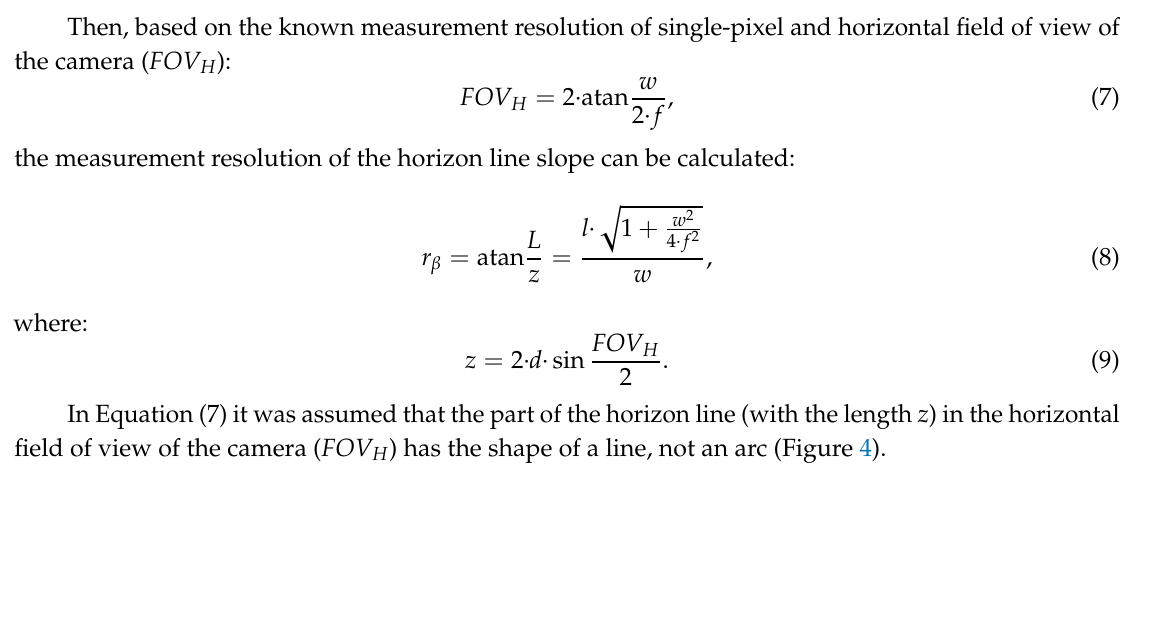
Figure 2. The idea of measuring the horizon line slope with a CMOS matrix camera.